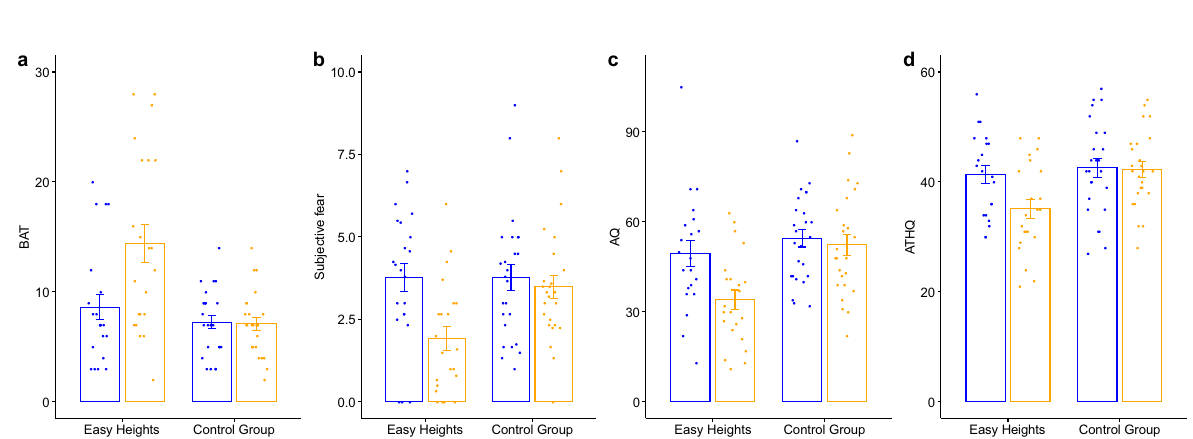
Fig. 2 Primary (Behavioral Avoidance Test, BAT) and secondary outcome measures (mean subjective fear on the tower during BAT, Acrophobia Questionnaire, AQ, Attitudes Towards Heights Questionnaire, ATHQ at baseline (represented with blue bars) and at phase 2 post intervention (represented with yellow bars). a Behavioral Avoidance Test (BAT): The range of the BAT score is 0 – 28 (1 point was given for reaching each platform and 1 point for looking down on each platform for 10 seconds). b Mean subjective fear on the tower during BAT: Mean subjective fear was calculated from the fear levels assessed on the reached platforms after looking down for 10 seconds. The range of the score is 0 – 10 (0 = no fear to 10 = maximum fear). c Acrophobia Questionnaire (AQ): The range of the AQ score is 0 – 120 with higher scores indicating higher severity. d Attitudes Towards Heights Questionnaire (ATHQ): The range of the ATHQ is 0 – 60 with higher scores indicating a more negative attitude towards heights. Means and standard errors are